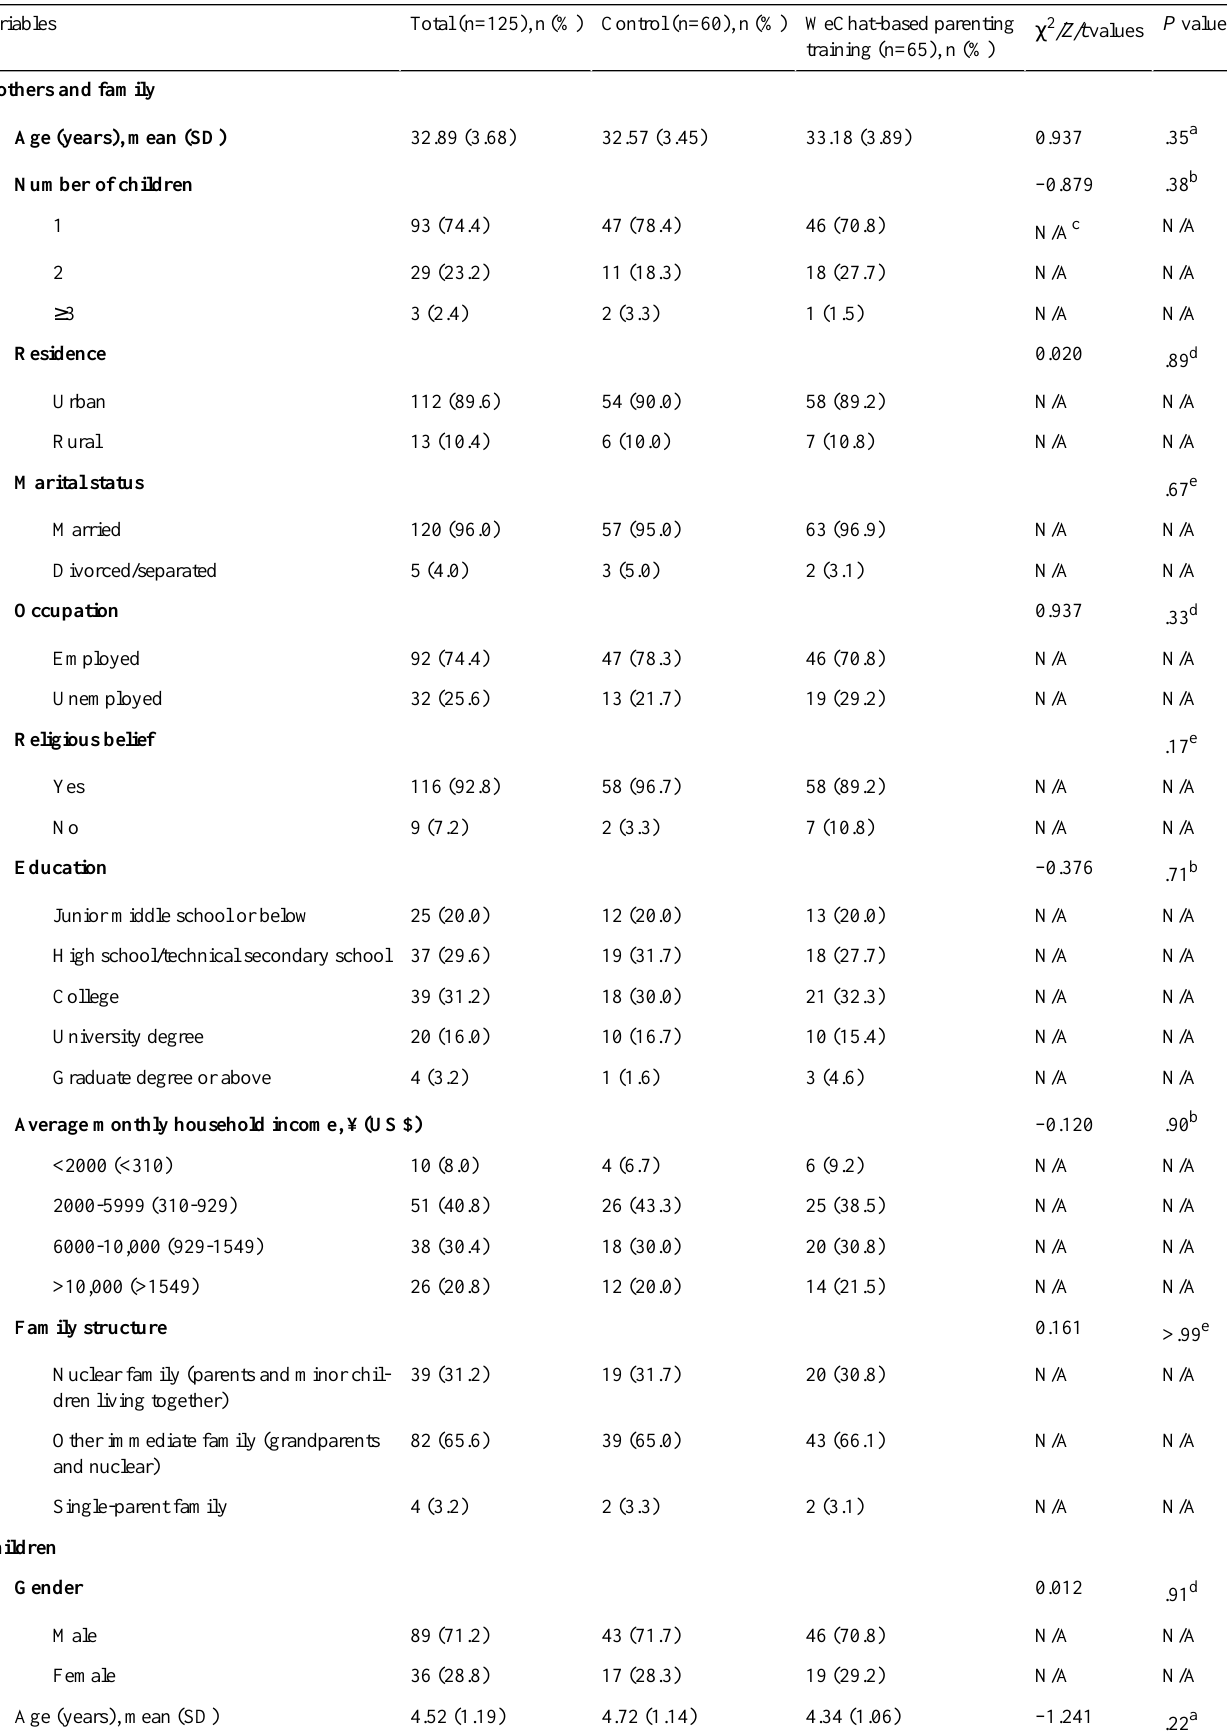
Table 1. Participants’baseline characteristics